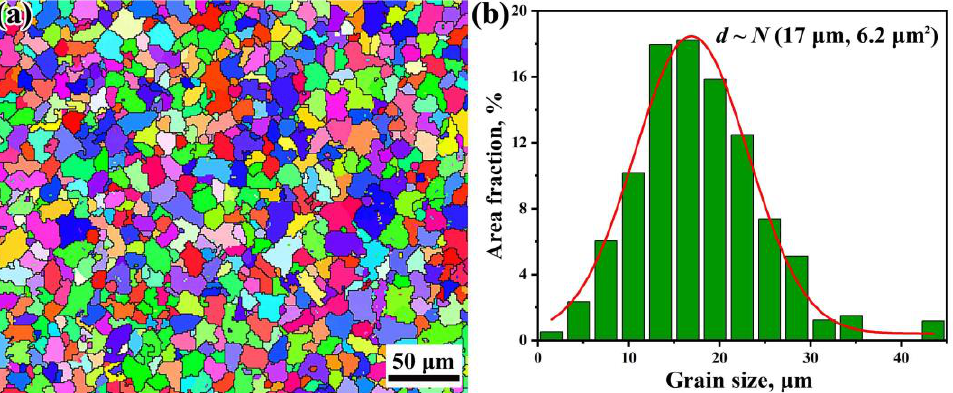
Figure 4. EBSD (electron backscatter diffraction) map of the grains ( a ) and its statistical distribu- tion of the effective grain size ( b